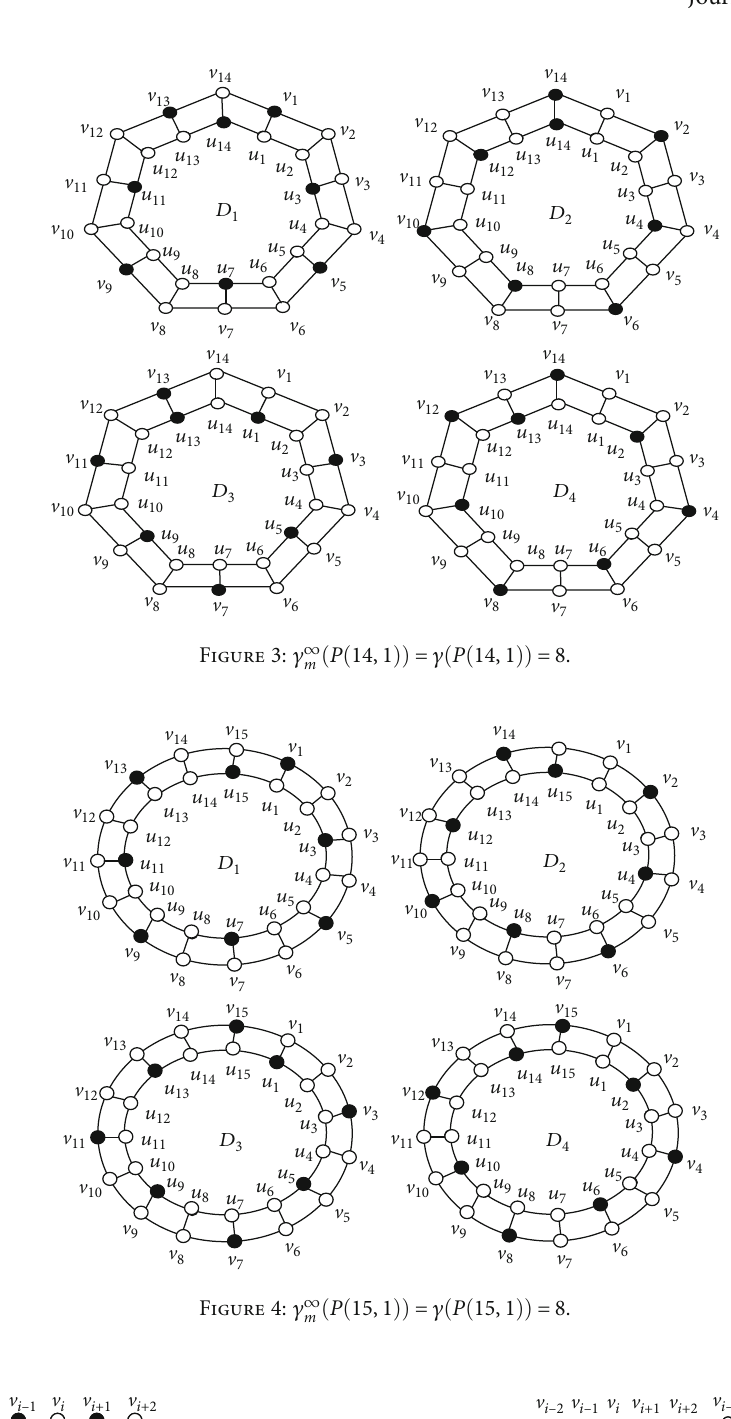
Figure 5: Dominating B